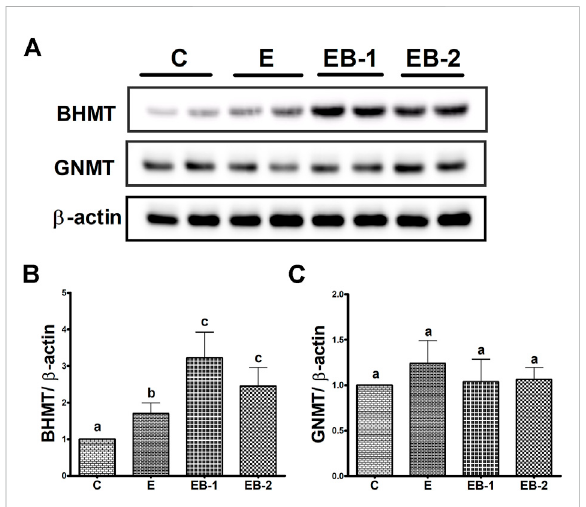
FIGURE 6 BHMT and GNMT protein quanti fi cation by Western